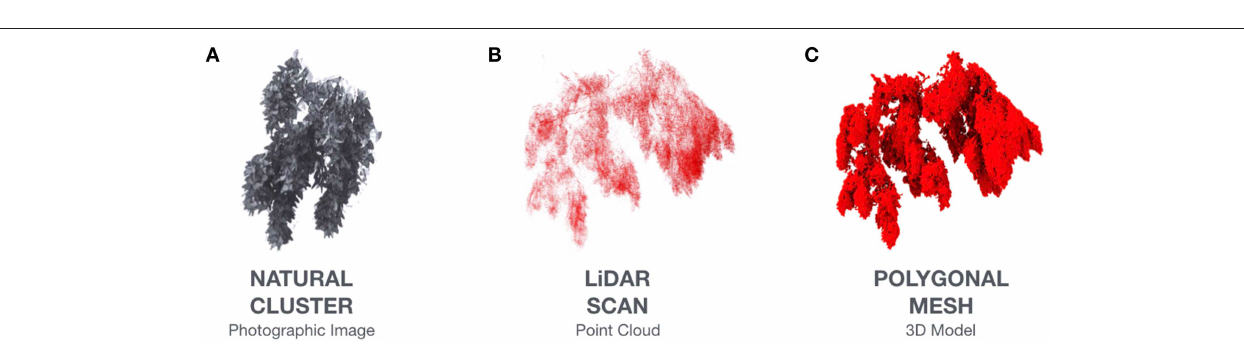
FIGURE 1 | The analysis of Terrestrial LiDAR Scanning (TLS) data follows a numerical model based on shape analysis. Subtractive Volume Estimation (SVE) compares a scan with butterflies, referred to as the reference scan, to a scan without butterflies, known as the derivative scan and calculates the difference between the two shapes. That difference represents the volume of butterflies present. The final estimated colony size is based on dividing that volume by a scaling factor, n , which represents the volume of an individual butterfly multiplied by a correction factor f that accounts for characteristics of the TLS survey.